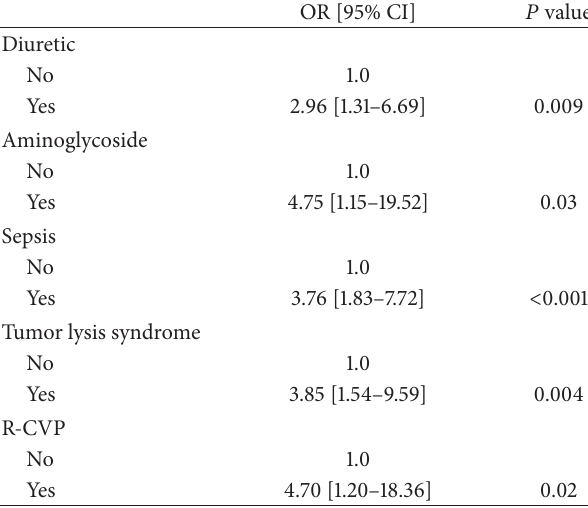
Table 3: Factors predicting